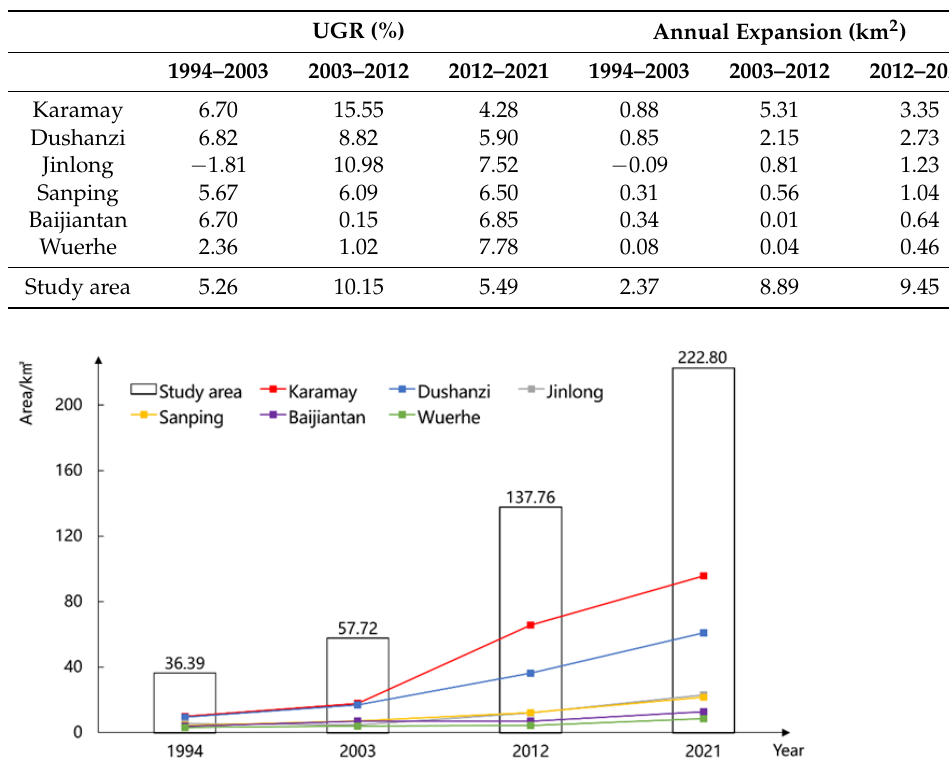
Figure 4. Changes in the area of urban construction land from 1994 to 2021. The values of URG are given in Table 2.